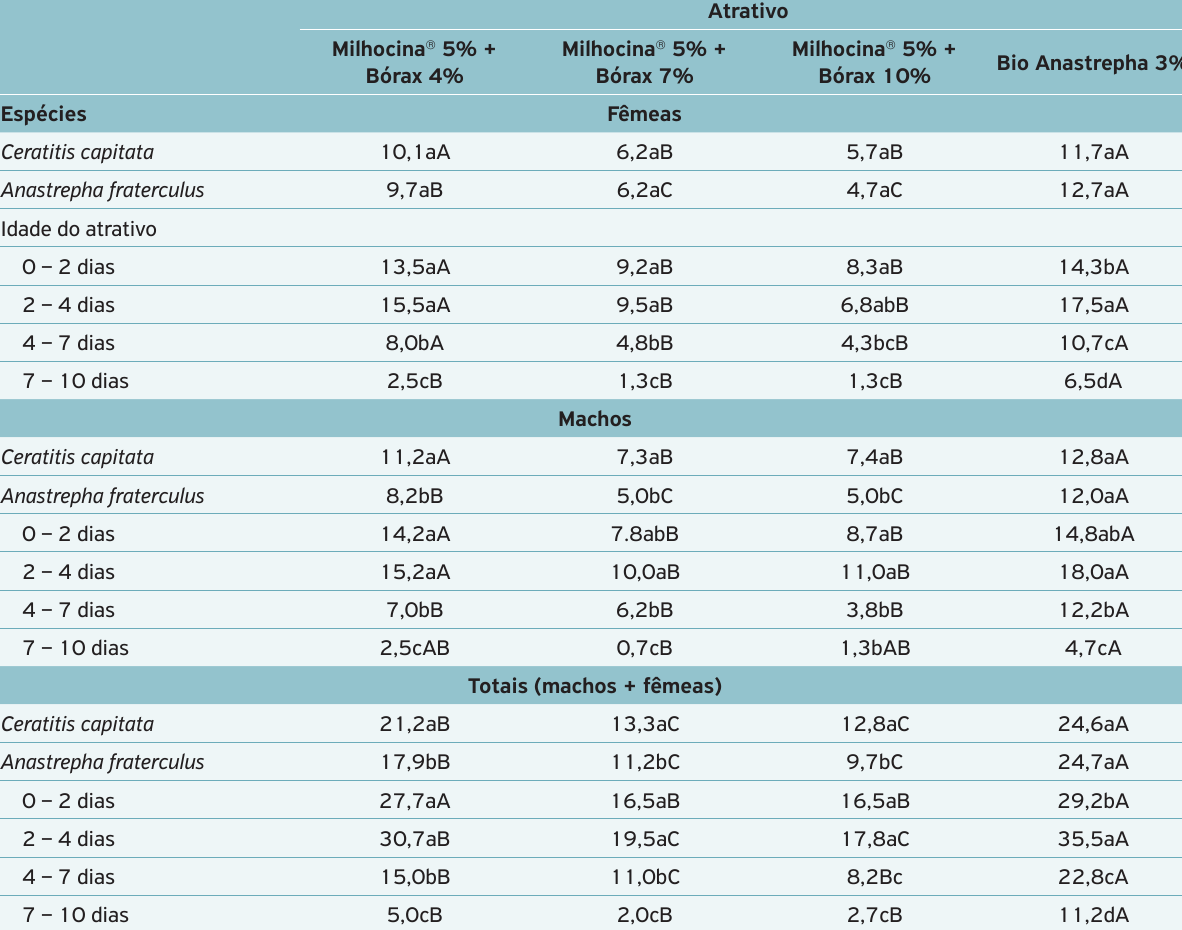
Tabela 1. Valores médios de fêmeas, machos e totais de Ceratitis capitata e de Anastrepha fraterculus capturados por armadilhas McPhail contendo diferentes atrativos alimentares, mantidas em gaiolões de campo durante quatro períodos de exposição. Campinas, São Paulo, janeiro a fevereiro de